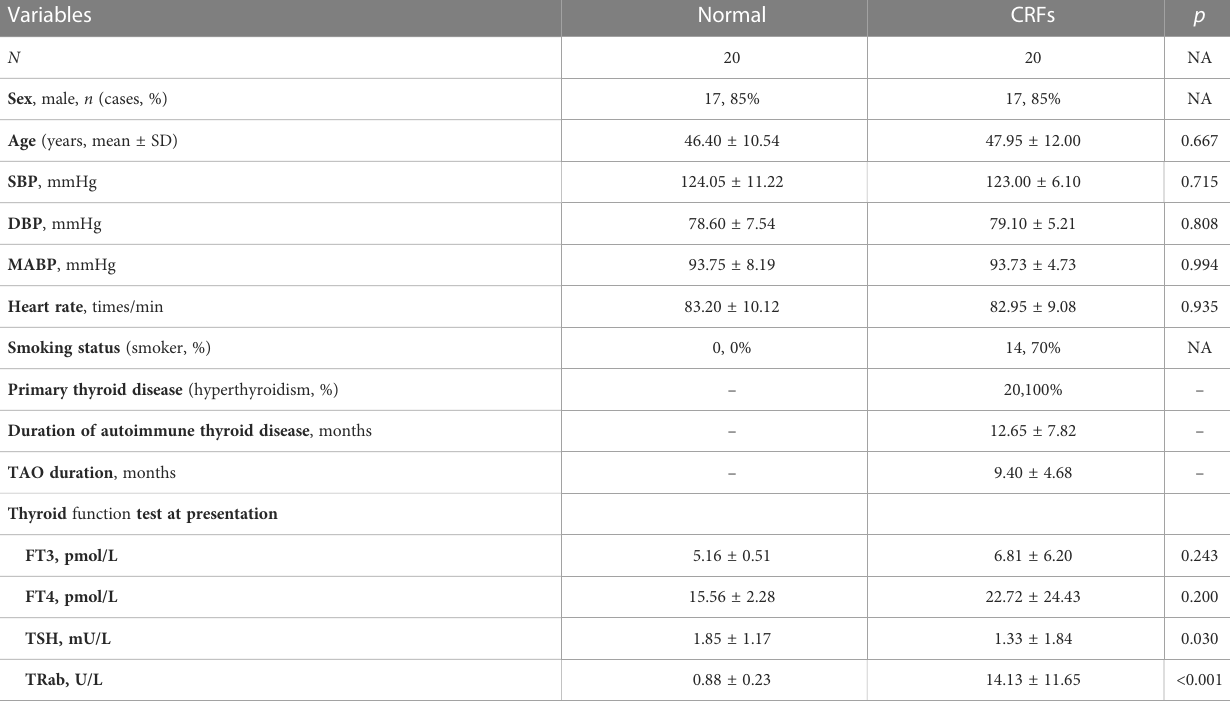
TABLE 1 Demographic and clinical